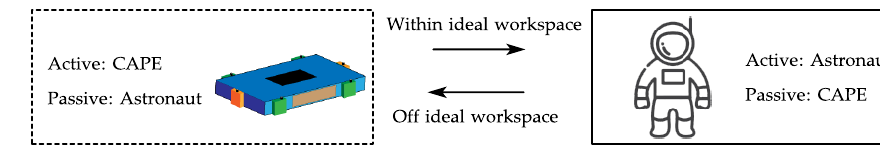
Figure 9. The passive and active switchover of